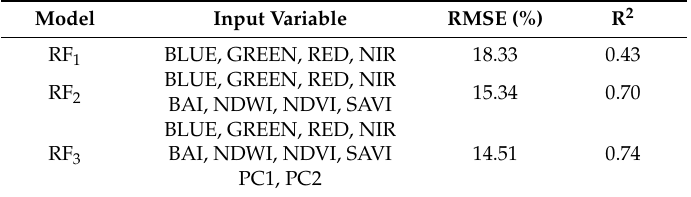
Table 4. Comparison of the di ff erent combinations of input variables for RF models.